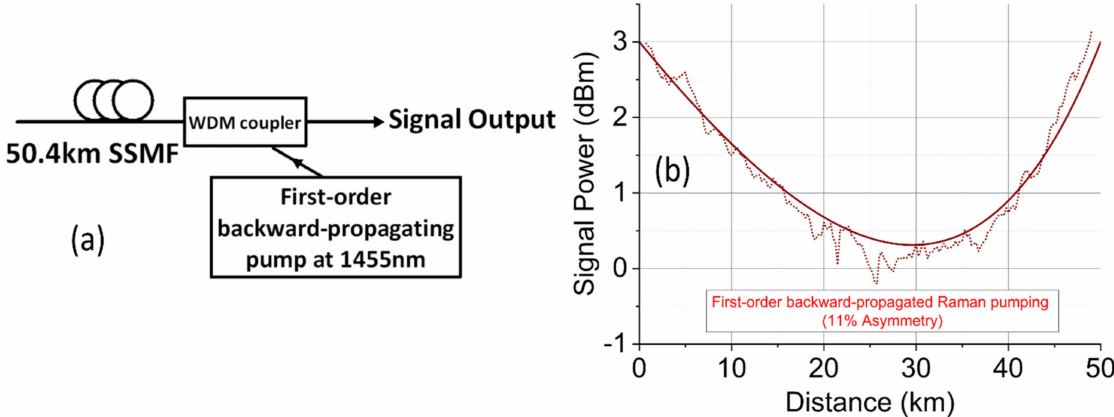
Figure 1. ( a ) First-order backward pumping; ( b ) signal power profiles along the